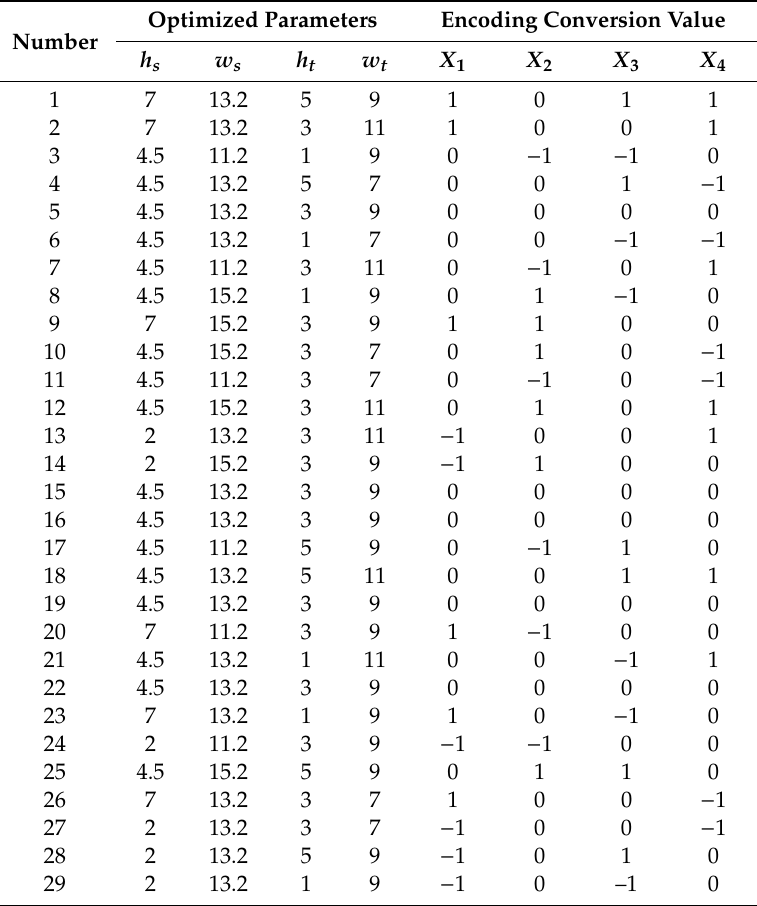
Table 2. Experiment schedule of tooth profile parameters